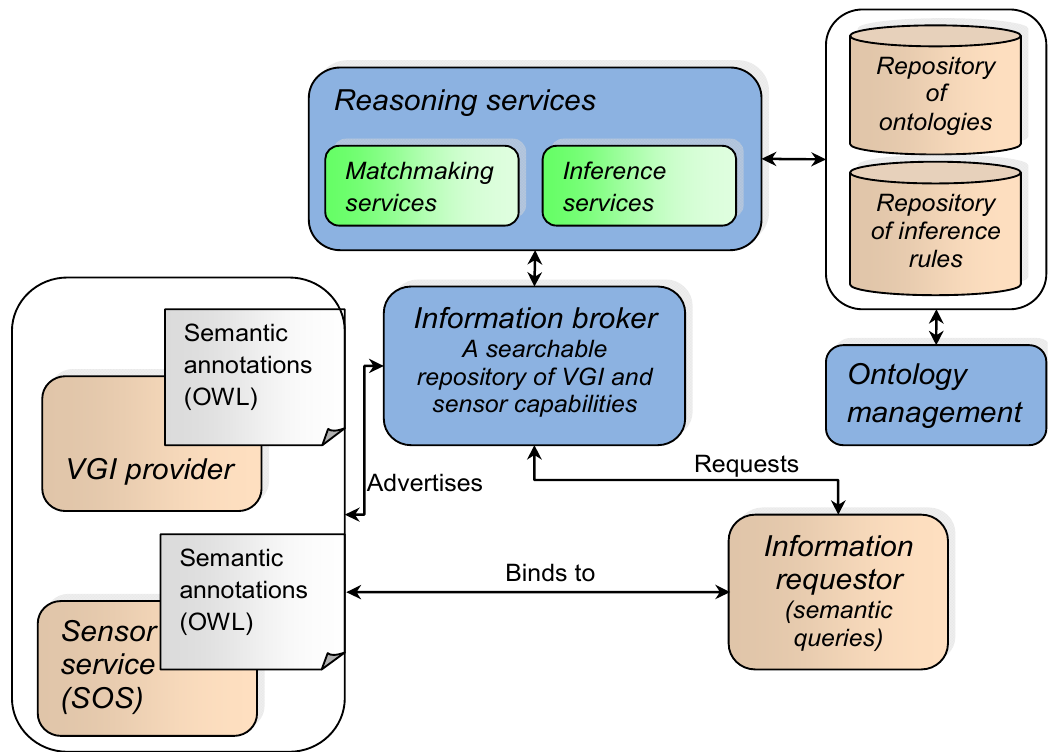
Figure 6. Components within the semantic